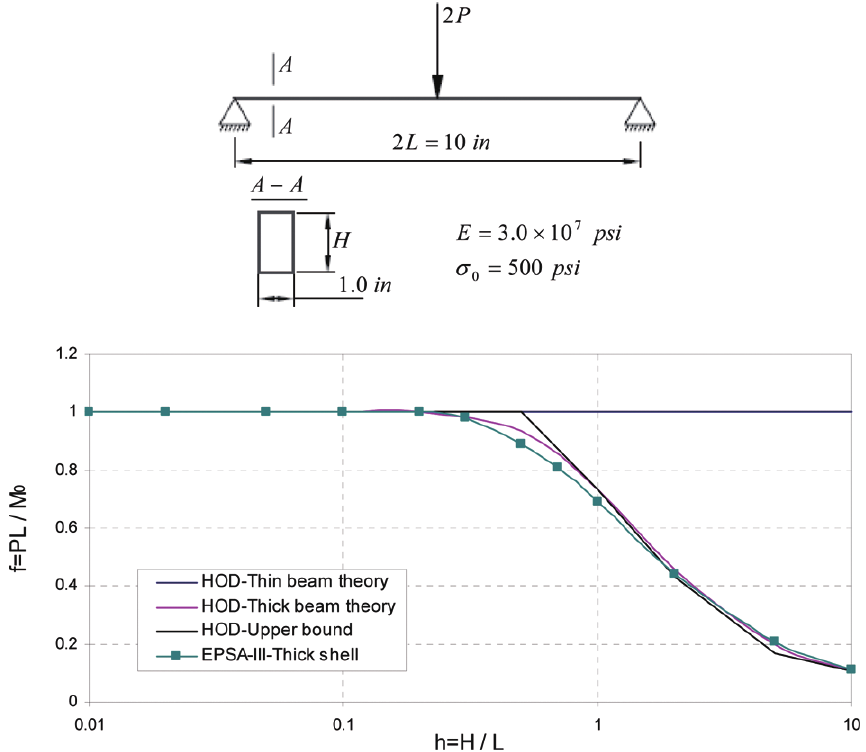
Fig. 11. Simply supported beam – geometry, material properties, and results; collapse load as a function of thickness (HOD-Hodge [11]). load factor with increasing thickness. To test the accuracy of our formulation in accounting for shear deformation, we consider a simply supported beam of length 2 L = 10 in , subjected to a concentrated load 2 P at its